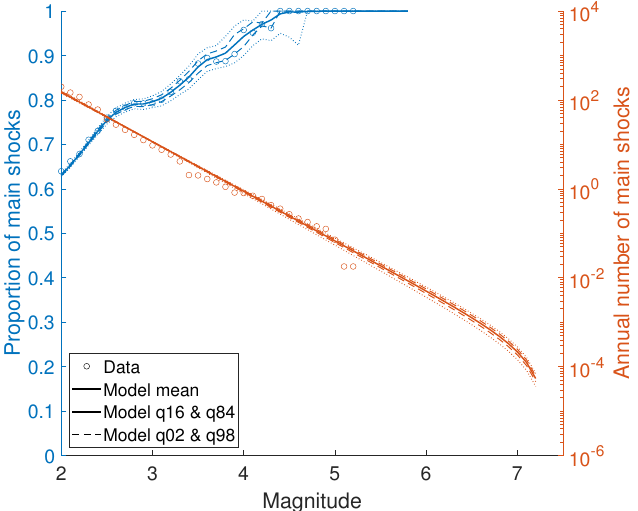
Figure 7. Proportion–Magnitude and Frequency–Magnitude Distributions (PMD and FMD) of main shocks for the whole of mainland France. The PMD is obtained by applying the G85 declustering algorithm [40] on data. A Regression of the GR law (Equation (10)) on data has been applied from M 2 to M 5 and has been extrapolated with the use of the truncated GR law (Equation